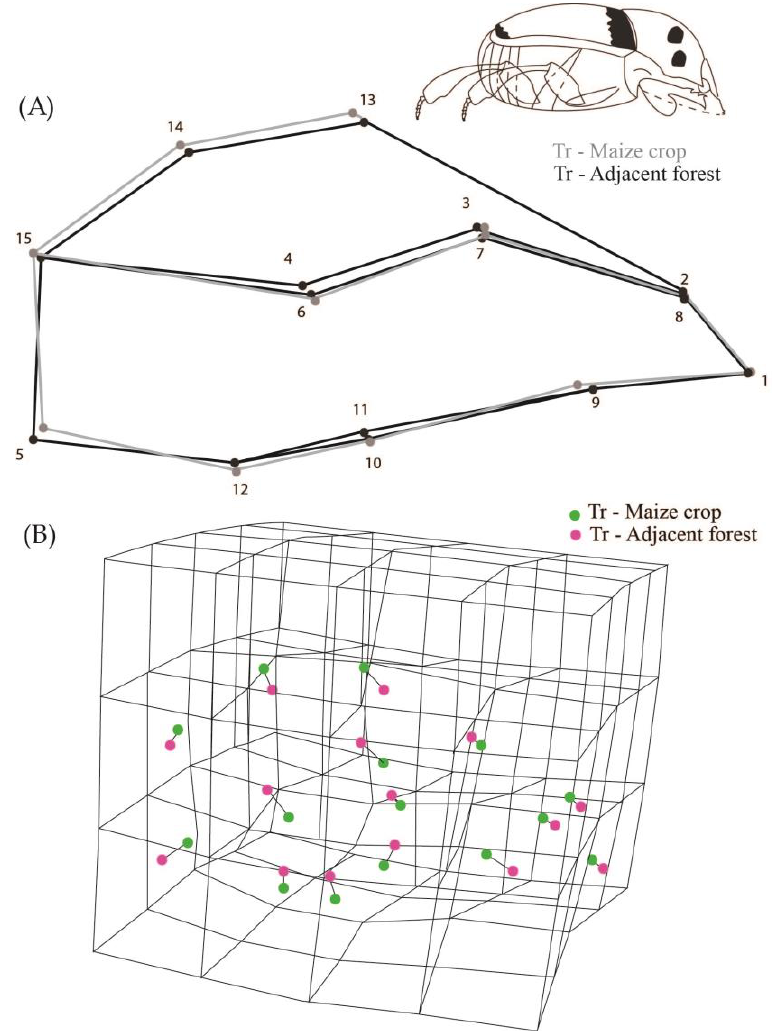
Figure 3. ( A ) 2D Graphical reconstruction of C . quinquemaculatus body shape. Gray lines show body shape of transgenic maize crop populations, and black lines show adjacent forest populations; ( B ) 3D Graphical reconstruction of C . quinquemaculatus body shape. Green dots: transgenic maize populations. Pink dots: adjacent forest populations.